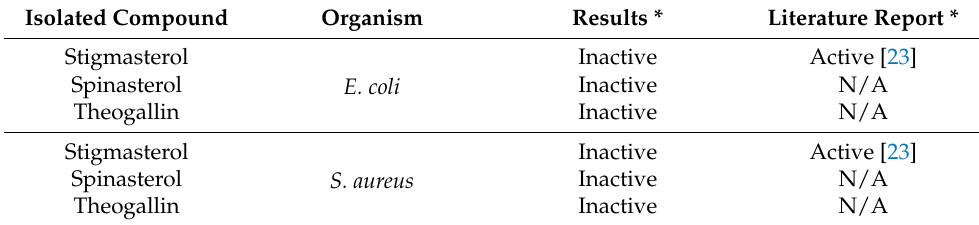
Table 4. The antibacterial activity of the metabolites identified in the acetone extracts of Acacia ehrenbergiana.